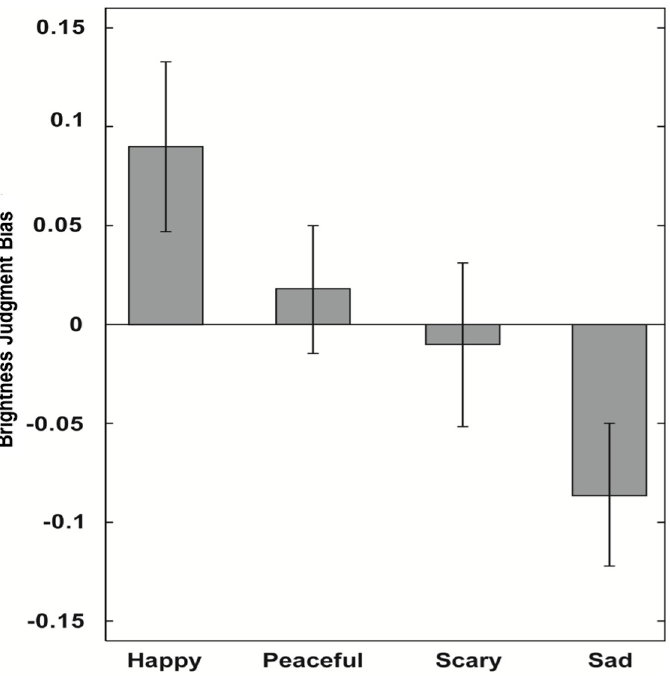
Fig 3. Results of Experiment 2. Brightness judgment biases, separately for happy, peaceful, scary, and sad excerpts. Error bars indicate SE of the mean.